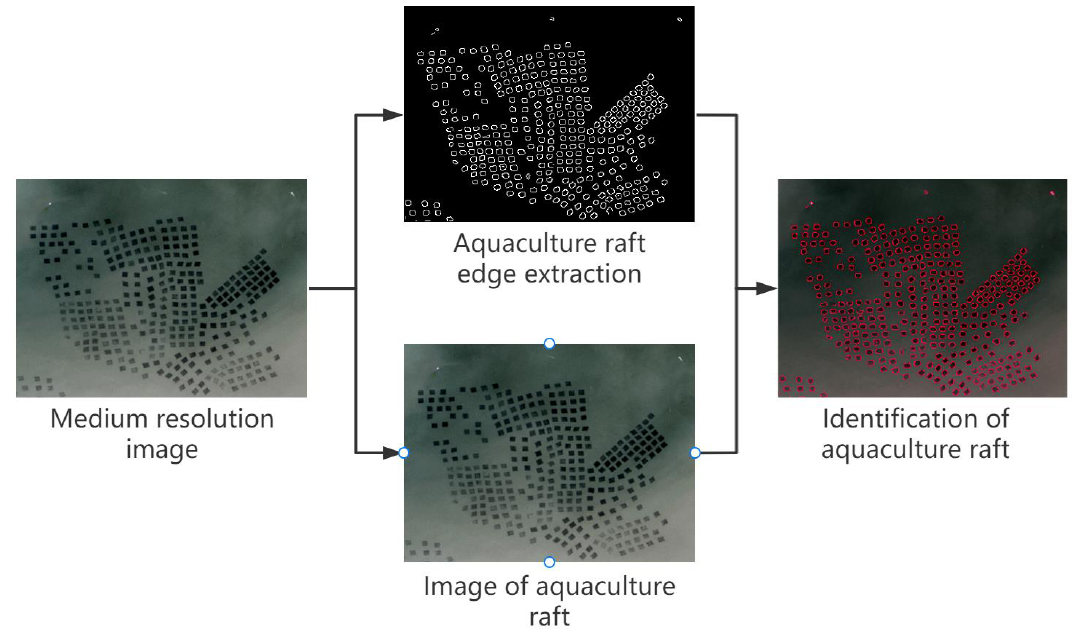
Figure 3. Extraction diagram of the culture area.